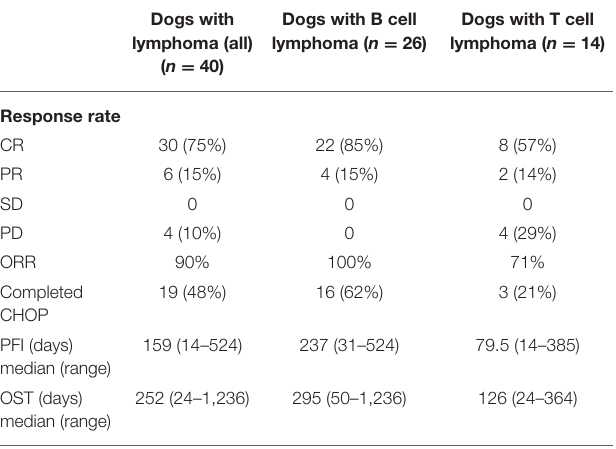
TABLE 2 | Outcome characteristics for dogs with multicentric lymphoma. Dogs with lymphoma (all)